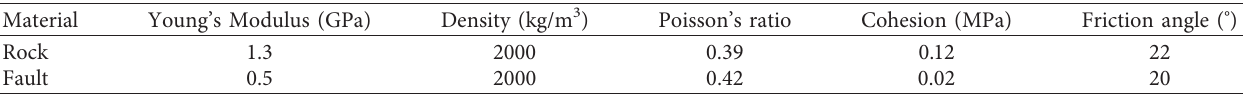
Table 3: Physical and mechanical parameters of the surrounding rock and fault fracture